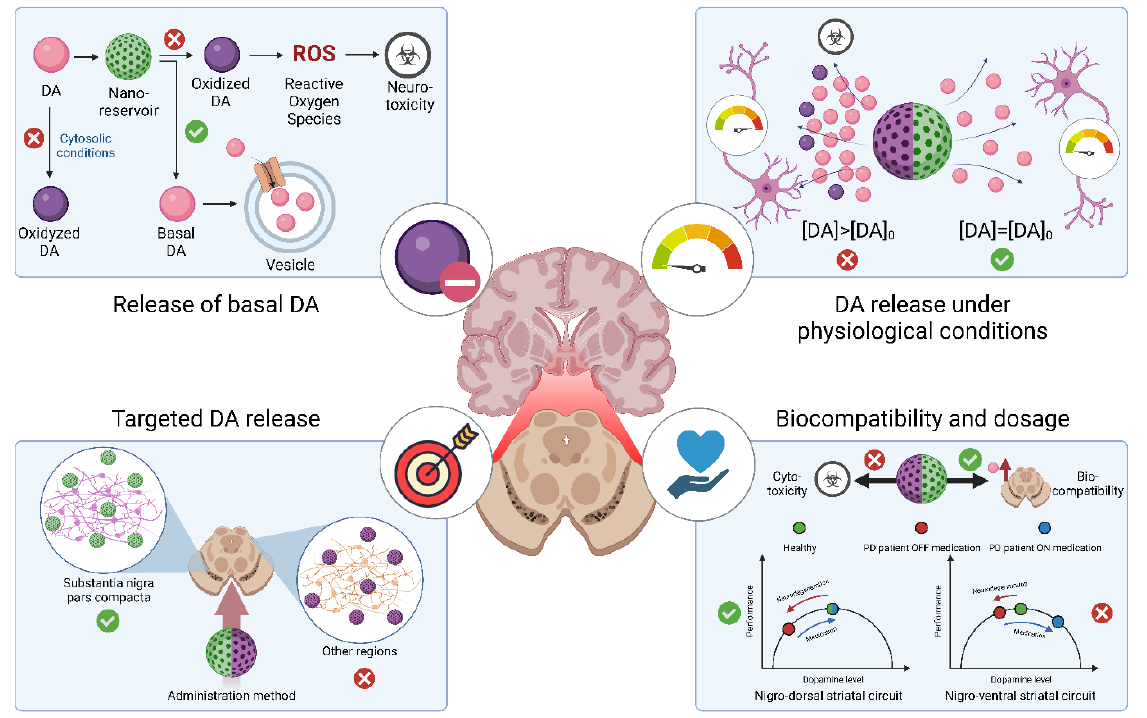
Figure 3. Conditions required for the development of novel nanostructure dopamine delivery systems. Firstly, the nanoreservoir must stabilize DA in its basal state, avoiding its oxidation until its release and encapsulation in synaptic vesicles since oxidized DA derivatives increase the production of ROS, which generates neurotoxicity. In addition, the release rates of stabilized DA must meet the physiological needs of dopaminergic neurons without exceeding physiological extracellular [DA] 0 concentrations. It must also be ensured that such release takes place only in the necessary regions, regardless of the method of administration, so that DA is not wasted or oxidized, causing neurotoxicity. Finally, the nanoreservoir must comply with the principle of biocompatibility and adequate dosage since an overdose of DA could lead to dysregulation of motor performance. DA: dopamine; ROS: reactive oxygen species. Figure made in BioRender.com.